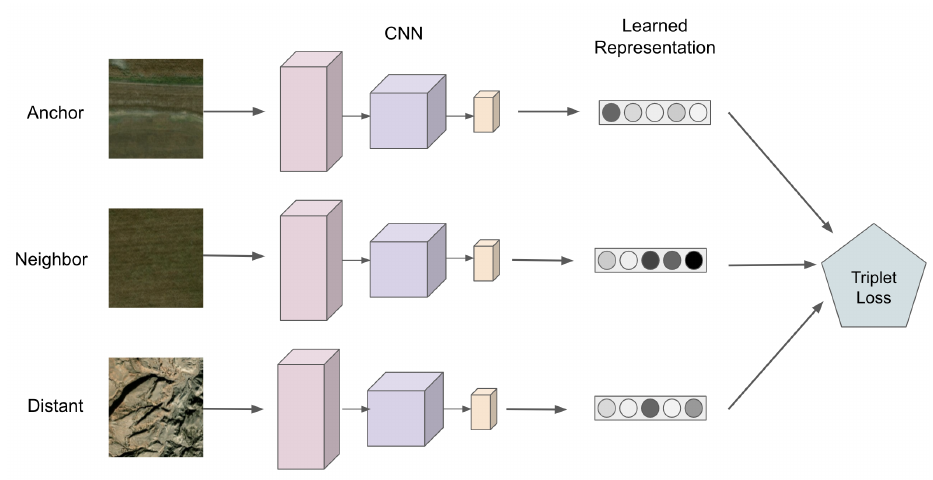
Figure 1. Schematic diagram of Tile2Vec model framework.